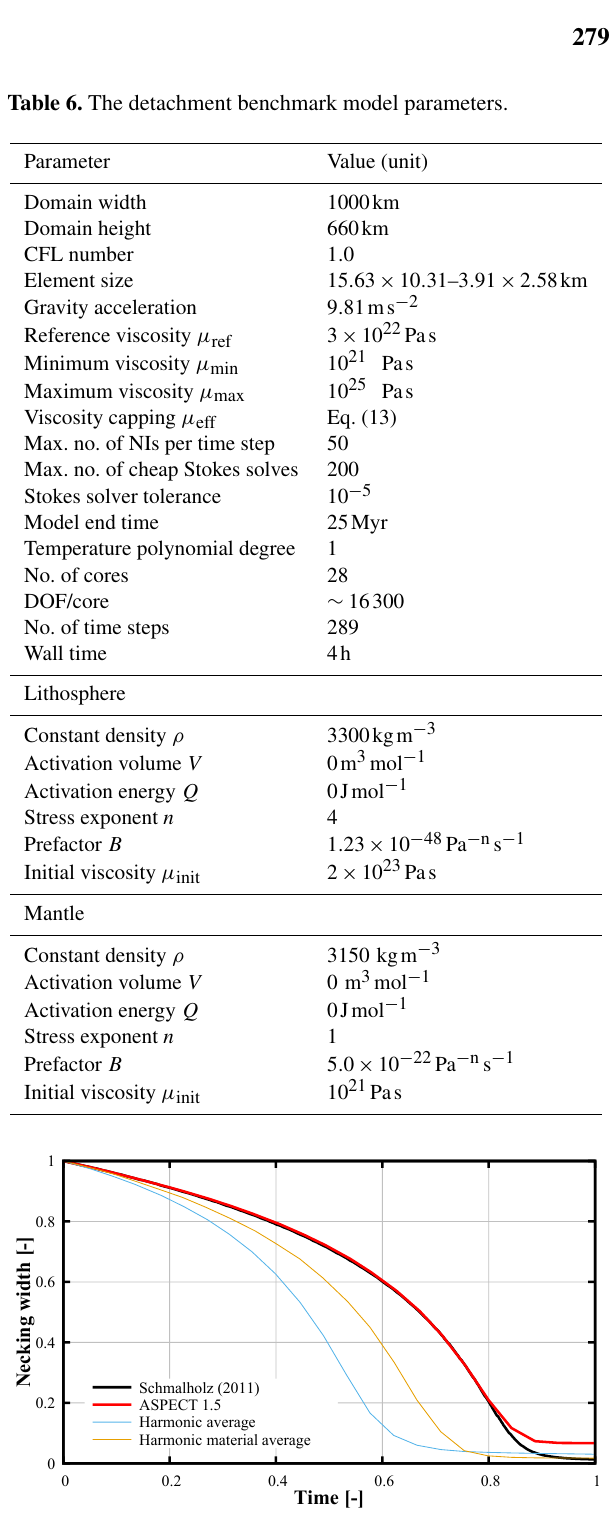
Figure 13. Nondimensional necking width versus time for AS- PECT and Schmalholz (2011). The ASPECT necking width is cal- culated from the 20 tracer positions. Because the tracers above the necking zone no longer move after detachment, the thus-calculated width stagnates after t (cid:39) 0 .